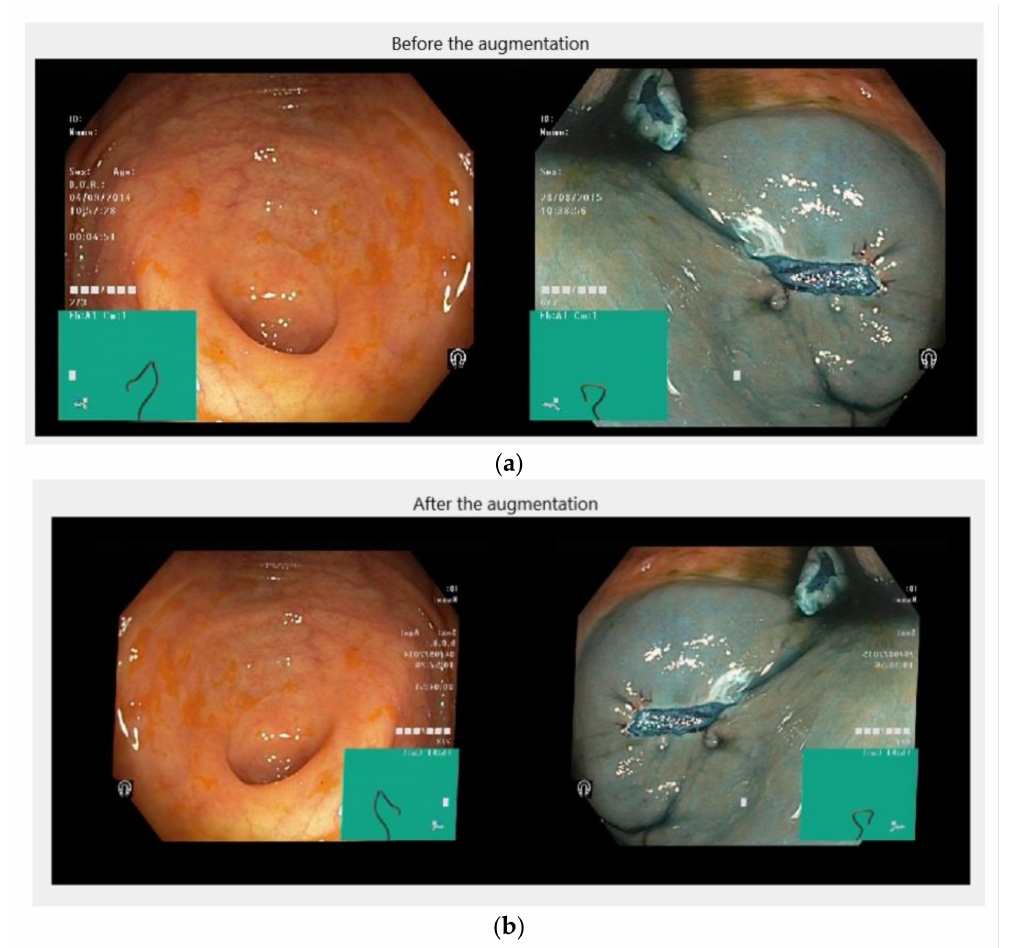
Figure 6. ( a ) Before and ( b ) after